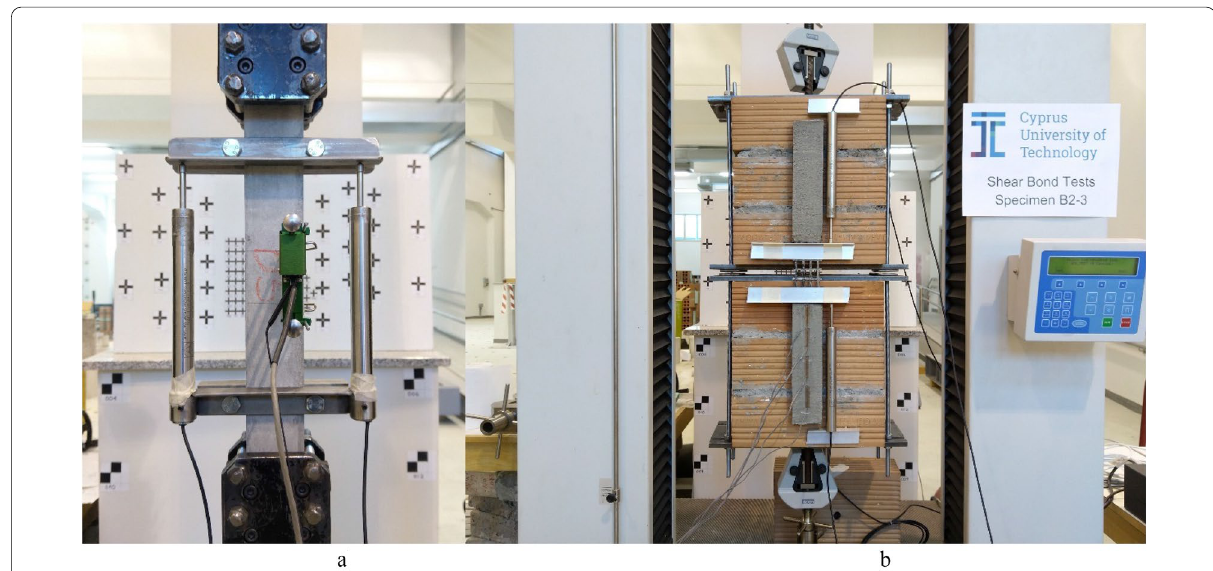
Fig. 6 Test setup: a direct tensile test, b shear bond